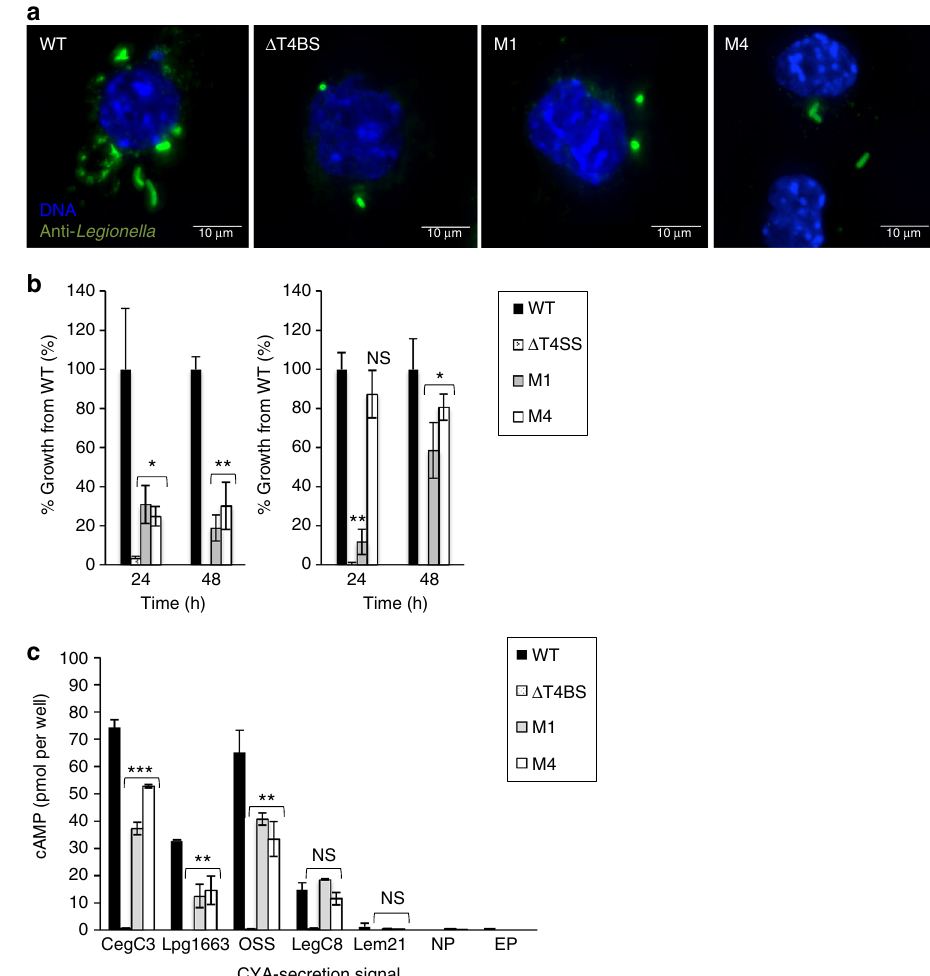
Fig. 6 Survival and transfer activity of binding-defective DotM Legionella mutants. a J774A.1 mouse macrophage-like cells were infected for 2 h with wild- type (WT) L. pneumophila (Lp01), T4BS system-de fi cient L pneumophila ( Δ T4BS) or isogenic strains containing the indicated dotM mutations (M1 or M4), and fi xed using 4% PFA. Bacteria were stained with anti- L. pneumophila antibody and a secondary antibody labeled with Alexa fl uor 488 (green), while the host cell DNA was stained using DAPI (blue). Stacked images are shown in each panel. Bar = 10 μ m. b Intracellular growth of L. pneumophila strain Lp01 and isogenic strains producing the binding-defective DotM proteins M1 and M4. The intracellular growth of these L. pneumophila strains were determined in J774A.1 cells (left panel), and the protozoan host A. castellanii (right panel) as described in Methods. Graphs report colony-forming units ± standard deviation for each strain as percentages compared to wild-type. Bacteria were counted after either 24 or 48 h post infection as described in Methods. *, **, and *** indicate P values < 0.05, < 0.01, and < 0.001, respectively. c Translocation of Cya fusions by L. pneumophila into host eukaryotic cells. The ability of various effectors C-terminal translocation signals to translocate a reporter Cya was monitored in DotM wild-type or binding-defective mutants Legionella backgrounds by measuring cAMP levels in host cells 90 min after infection as described in Methods. Translocation levels are shown for the L. pneumophila wild-type (WT) strain, the T4BS system-defective strain ( Δ T4BS), and the L. pneumophila dotM mutants M1 and M4, as well as for bacteria without a plasmid (NP) and with unfused Cya (EP; shown only for WT). *, **, and *** indicate P values < 0.05, < 0.01, and < 0.001,